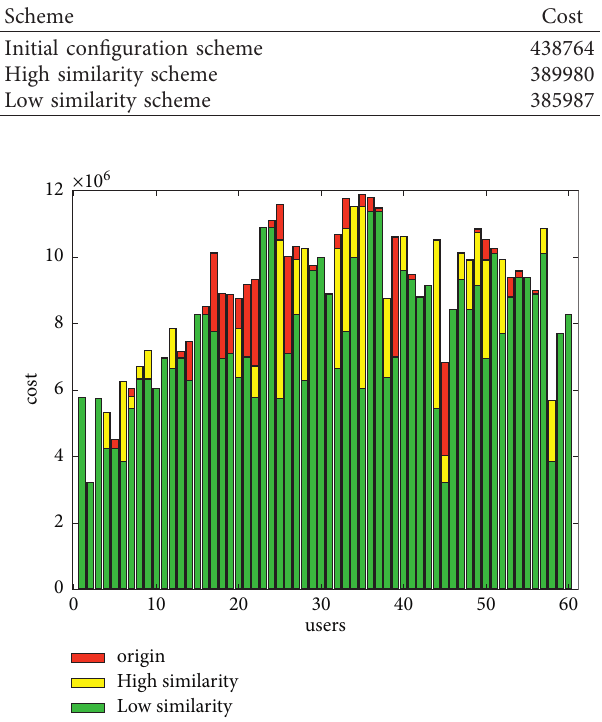
Figure 7: Cost after optimization.